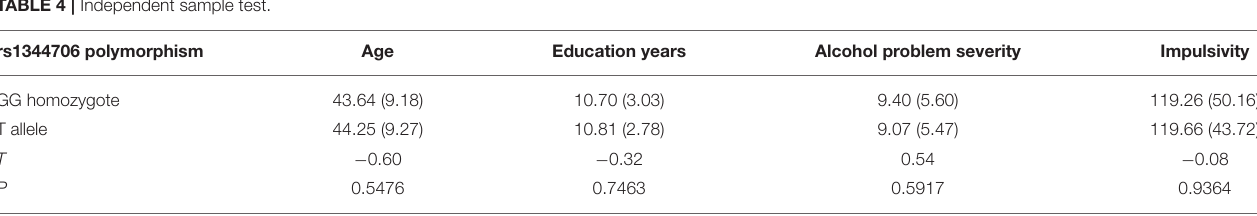
TABLE 4 | Independent sample